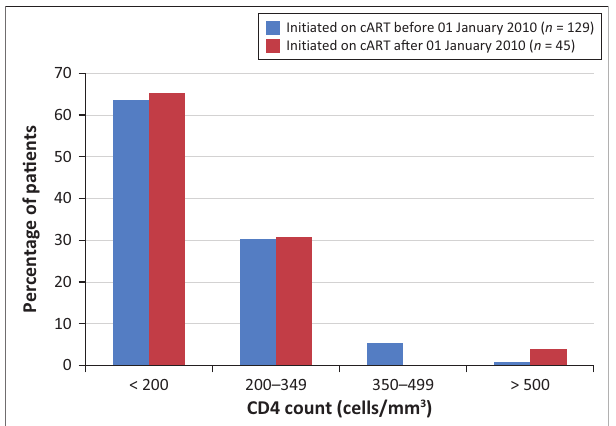
FIGURE 4: CD4 count at initiation of combination antiretroviral therapy of patients started before 01 January 2010 and those started after 01 January 2010. TABLE 5: First-line combination antiretroviral therapy regimens currently being used. First-line regimens